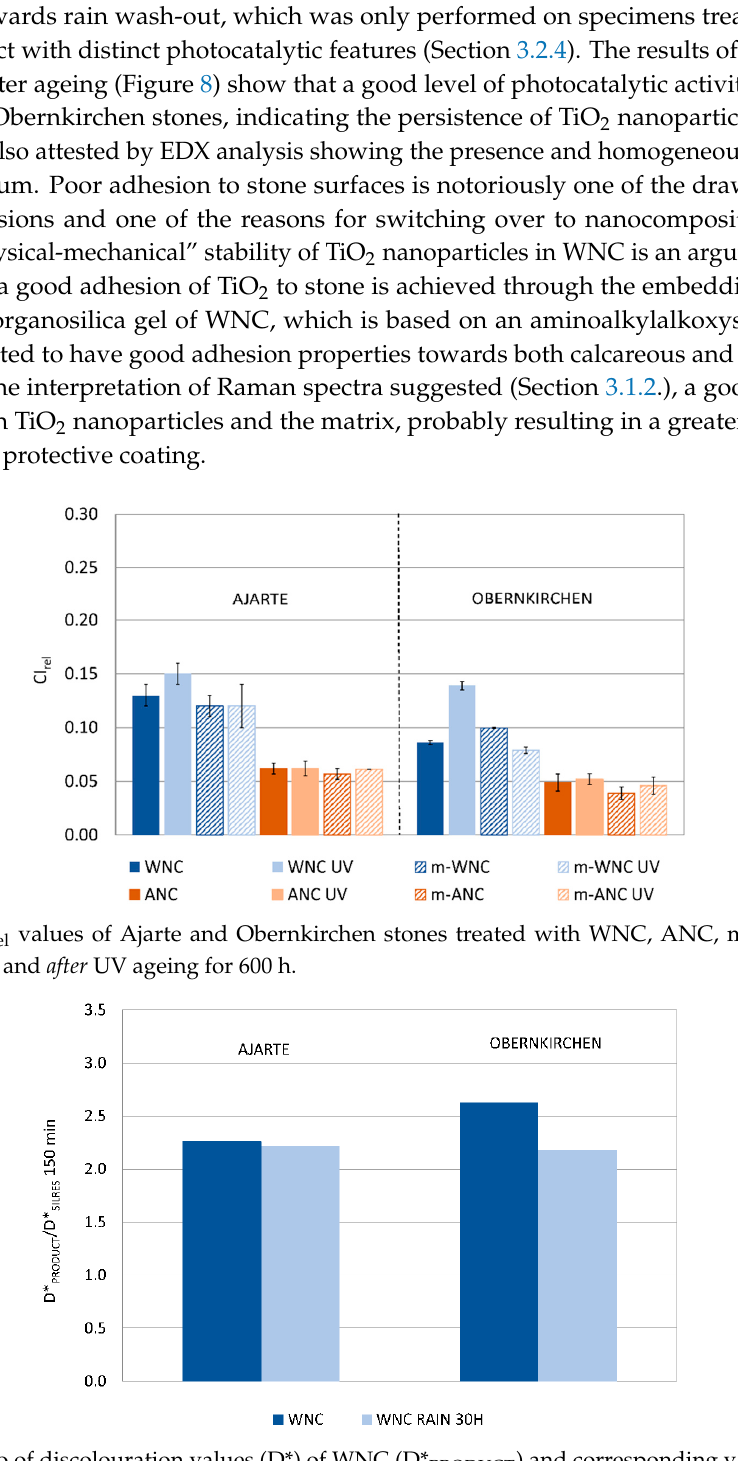
Figure 8. Ratio of discolouration values (D*) of WNC (D* PRODUCT ) and corresponding values for the reference non-photocatalytic product Silres BS 290 (D* SILRES ) at 150 min irradiation for Ajarte and Obernkirchen stones after rain ageing for 30 h.